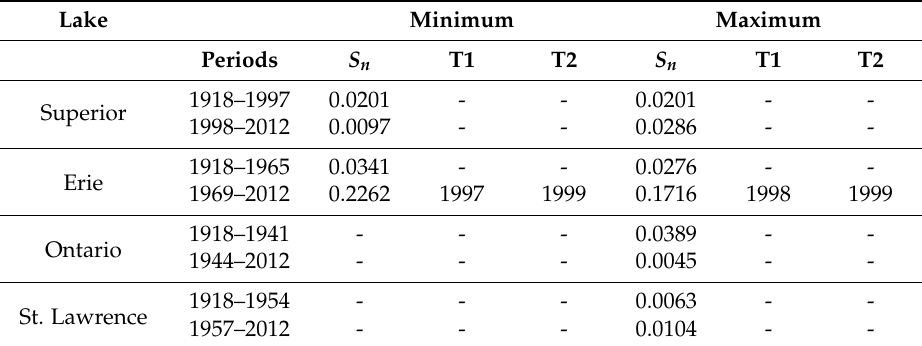
Table 2. Lombard method results for monthly mean water levels prior and after the first shift.